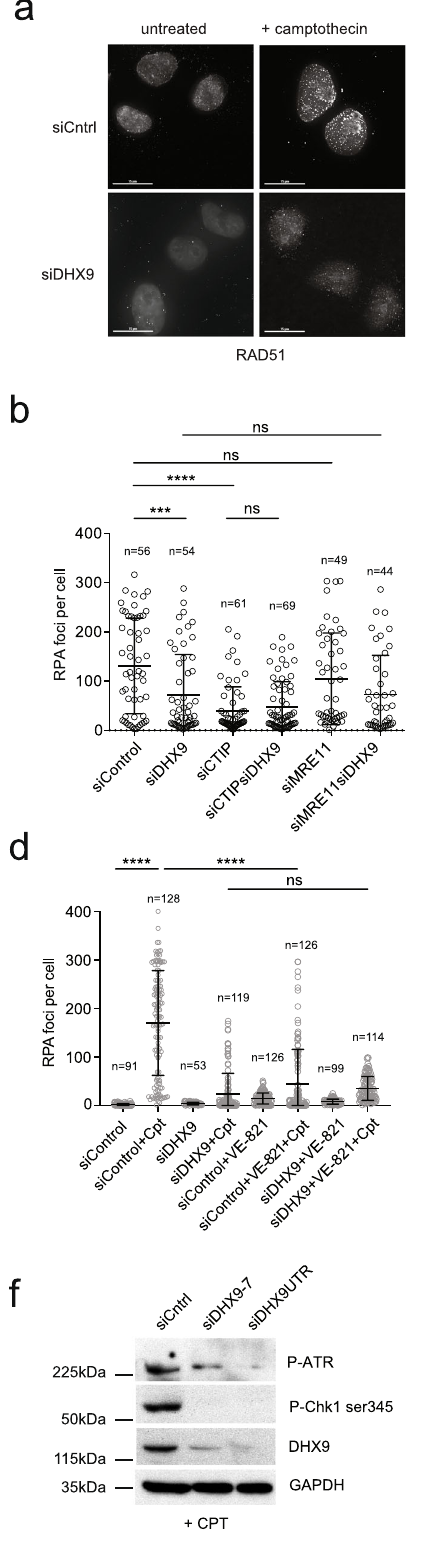
with BRCA1 and CTIP, processes top Icc blocked DNA ends making them permissive for DNA end resection and for repair synthesis in a reaction that is independent of pathway choice. Together, our data argue that DHX9 is a key component in the DDR, linking transcription with the processing and resection of broken DNA ends for